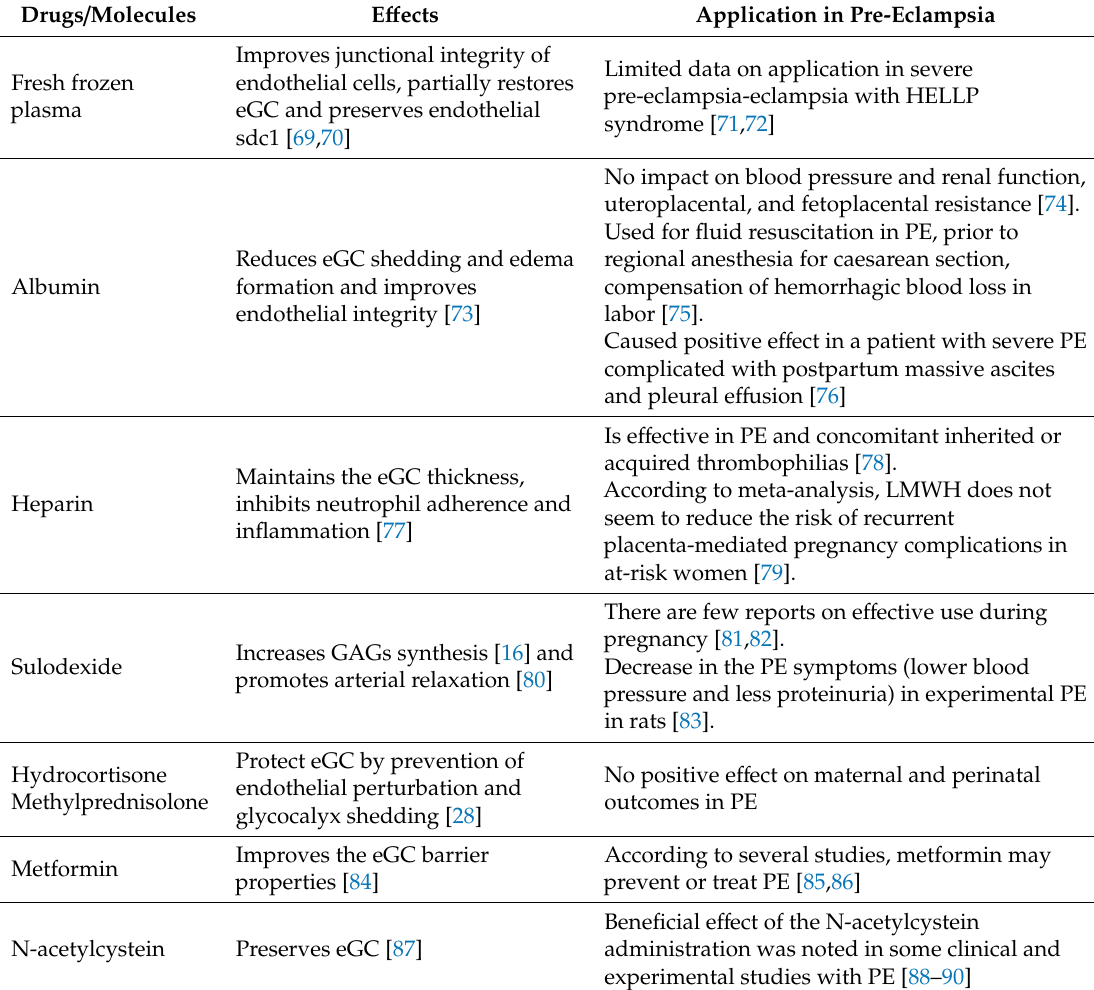
Table 3. Pharmacological protection and regeneration of the endothelial glycocalyx